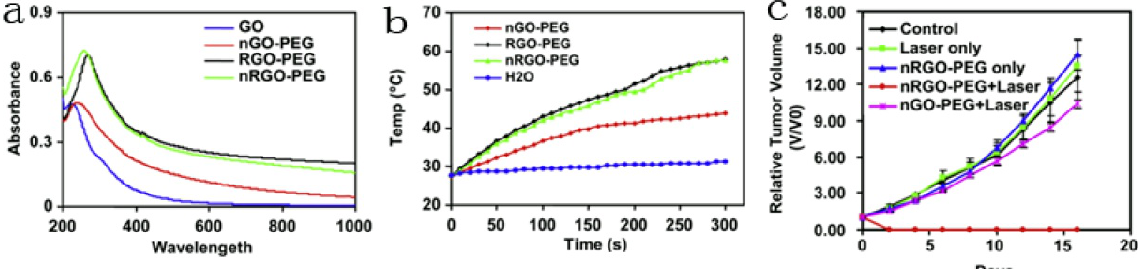
Fig. 3. (a) UVeVISeNIR spectra of as-prepared GO, nGO-PEG, RGO-PEG and nRGOPEG solutions at the graphene-concentration of 0.01 mg/ml. (b) Temperature change curves of water, nGO-PEG, RGO-PEG, and nRGO-PEG solutions exposed to the 808 nm laser at a power density of 1 W/cm 2 . In vivo photothermal therapy study using intravenously injected nRGO-PEG. (c) Tumor growth curves of different groups of mice after treatment. The tumor volumes were normalized to their initial sizes. Reprinted with permission from J. Liu, K. Liu, L. Feng // Biomaterials Science 5 (2017) 331. Copyright 2011 Elsevier